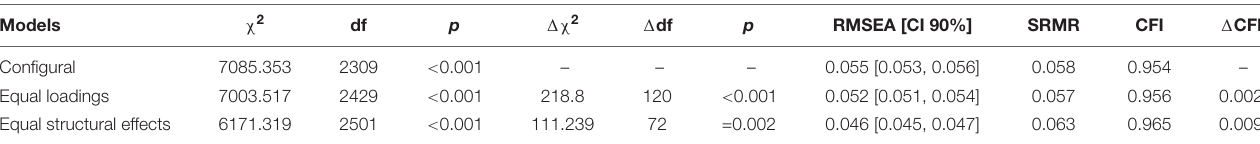
TABLE 5 | Model fit